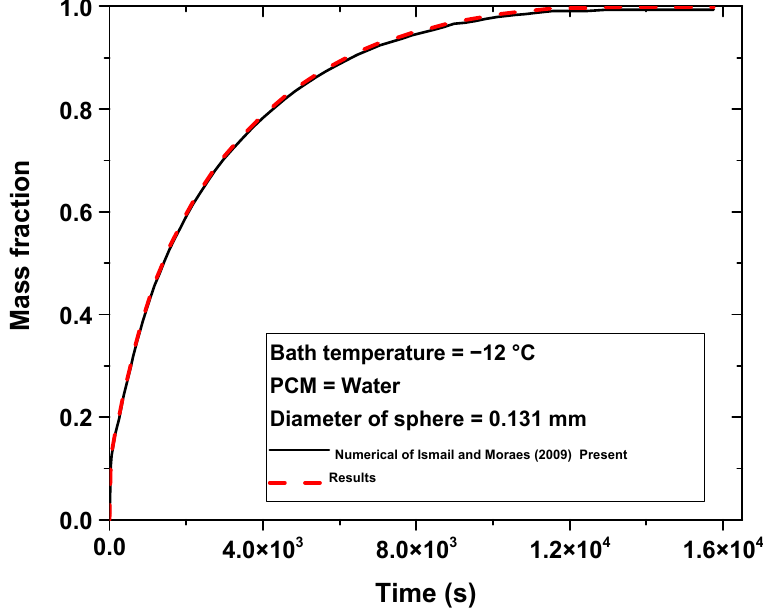
Figure 8. Comparison of the predicted mass fraction with the experimental data from [10].